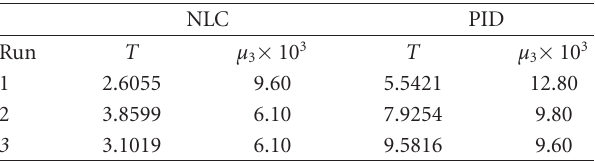
Table 4: IAE values generated when NLC and PID control strategies were